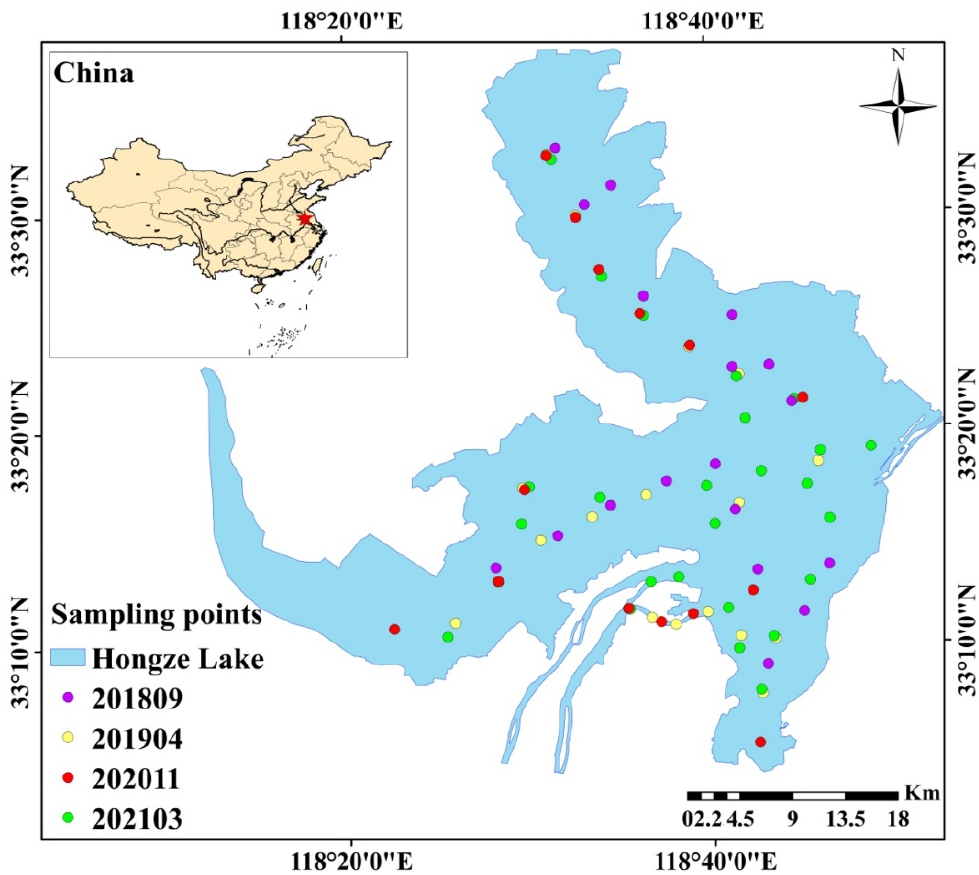
Figure 1. The study area and the distribution of sampling points.